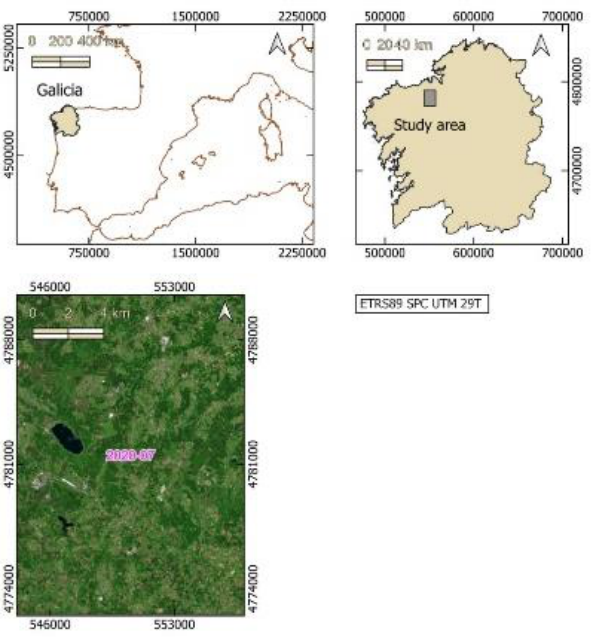
Figure 1. Study area. Reference image PNOA (National Aerial Orthophotography Plan, for its initials in Spanish) image (IGN, 2021).